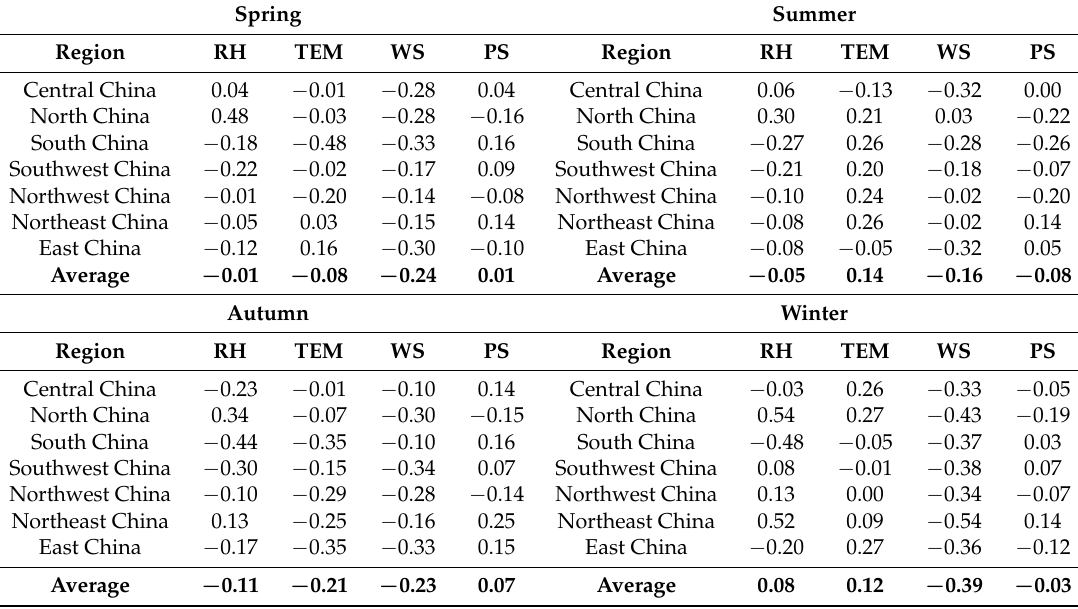
Table 3. The major and minor influencing factors of the seven regions (the color of each cell stands for the sign and magnitude of the correlation coefficient (r) value, where red stands for a positive correlation and blue stands for negative).